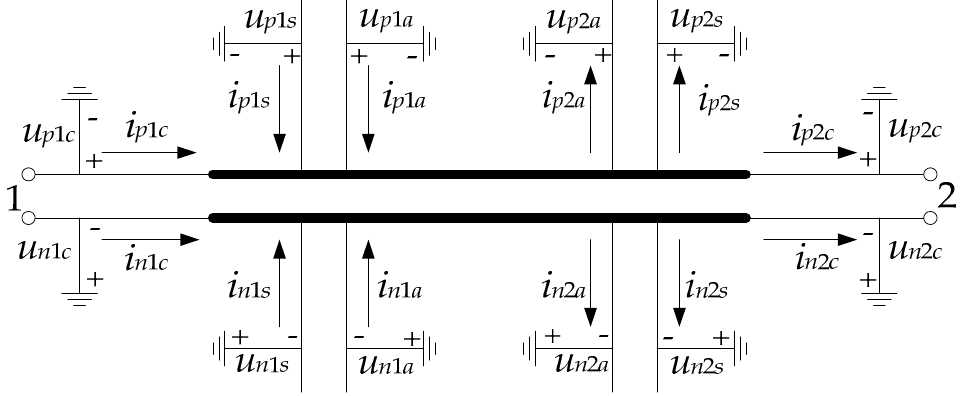
Figure 5. The schematic diagram of the bipolar DC cable.